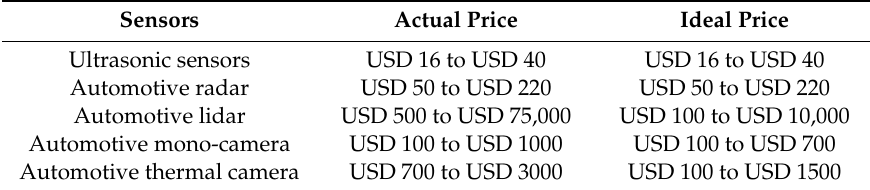
Table 2. Ideal price selection of sensors from the actual market price.